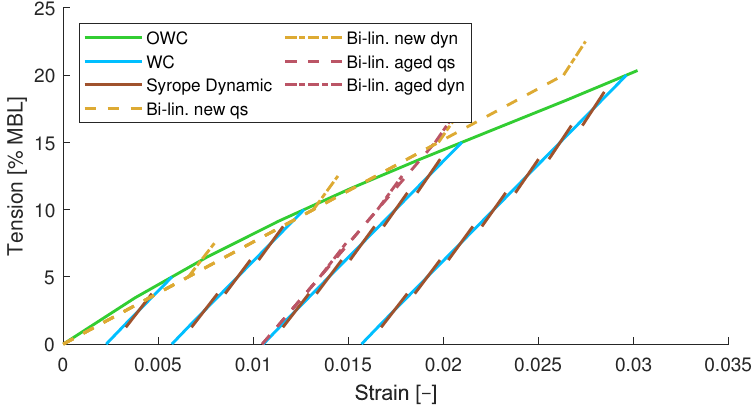
Figure 5. Syrope and bi–linear stiffness models for the fibre rope.